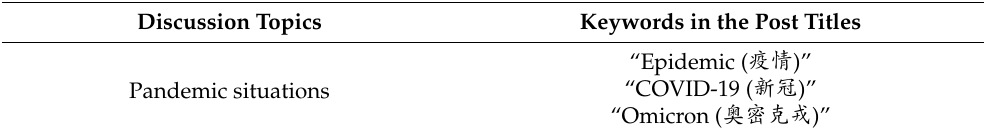
Table 1. A research list of Zhejiang University students’ online discussion topics and keywords in their post titles on